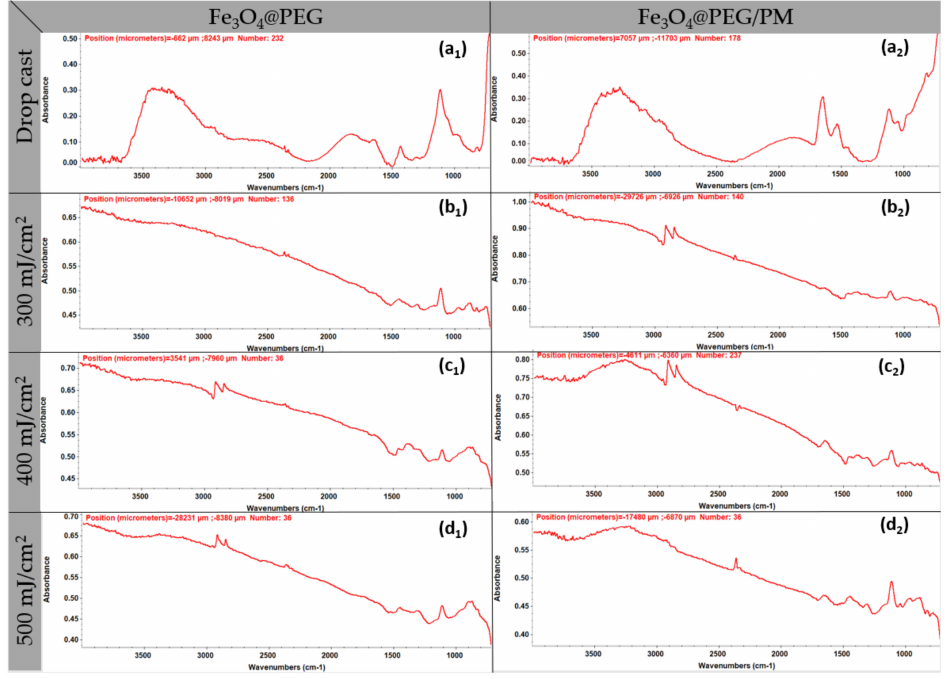
Figure 7. IR spectra of Fe 3 O 4 @PEG (1) and Fe 3 O 4 @PEG/PM (2): dropcast ( a ), F = 300 mJ/cm 2 ( b ), F = 400 mJ/cm 2 ( c ), F = 500 mJ/cm 2 ( d